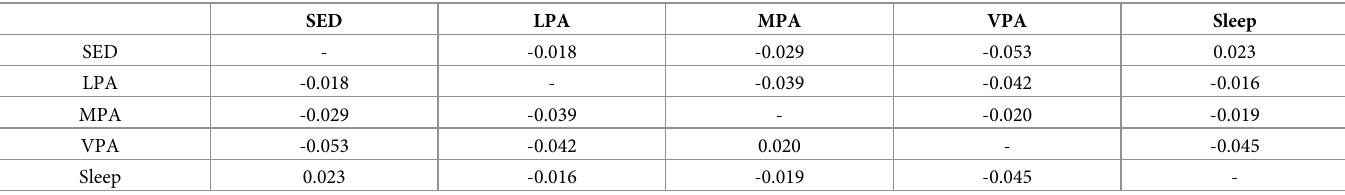
Table 3. Pair-wise log ratio variation matrix in the full sample.